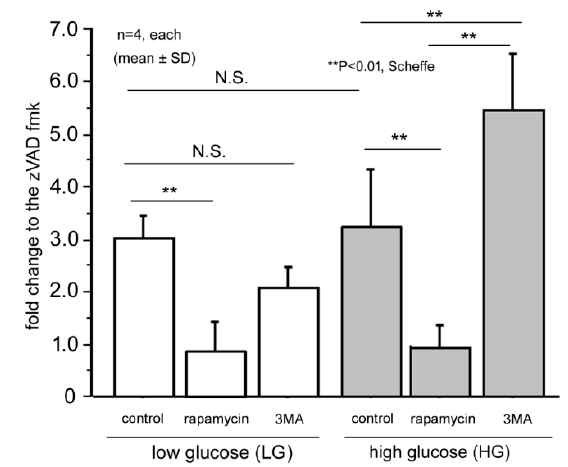
Figure 5. Caspase 3/7 activities in each condition. Data are expressed by the fold changes to the zVAD fmk control. The levels were similar between the LG and HG controls. Rapamycin decreased the activities to the levels of zVAD fmk control under both conditions. Inhibition of autophagy by 3MA increases the caspase activities under HG condition, while the levels were unchanged under LG condition. Thus, impairment of autophagy by 3MA increased apoptotic changes of 661 W cells under HG conditions. ** p < 0.01, Sche ff e; n = 4